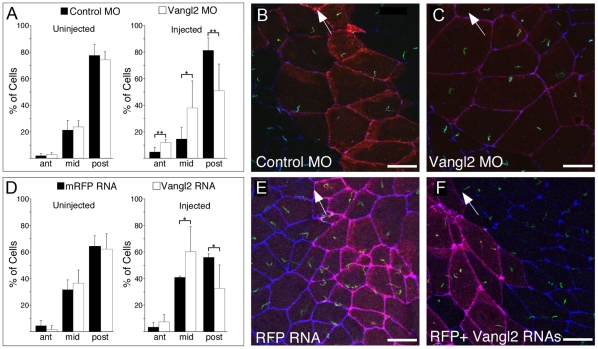

Vangl2 Morpholino or RNA alters positioning of cilia in the GRP.(A, D) A clone of cells in the GRP was generated by injecting one dorsal blastomere of 8-cell stage embryos with Vangl2 MO or a Vangl2 RNA, along with RFP RNA as a tracer or as a control. At stages 17/18, the dorsal half of the embryo was removed, fixed, and stained with antibodies directed to ZO-1 and acetylated–tubulin to mark cell boundaries and cilia, respectively. GRP cilia both inside (injected) and outside (uninjected) the clone were scored based on the location in GRP cells that were divided into three equal zones (anterior, middle and posterior). Shown are data from a minimum of 3 GRPs where 100–200 injected and uninjected cells were scored. Asterisks (* = p<0.05, ** = p<0.01.) represent p-values obtained using a two-tailed t-test. (B–C, E–F) Shown are confocal images of the GRP injected with the Vangl2 MO and RFP RNA (C), with Control MO and RFP RNA (B), with Vangl2 and RFP RNAs (F) or with RFP RNA alone (E). RFP (red) marks the position of the injected clone, cilia (green) are stained with the acetylated-tubulin antibody, and cell boundaries (blue) are stained with an antibody to ZO-1. Anterior is indicated by direction of the arrow in B, C, E, F.